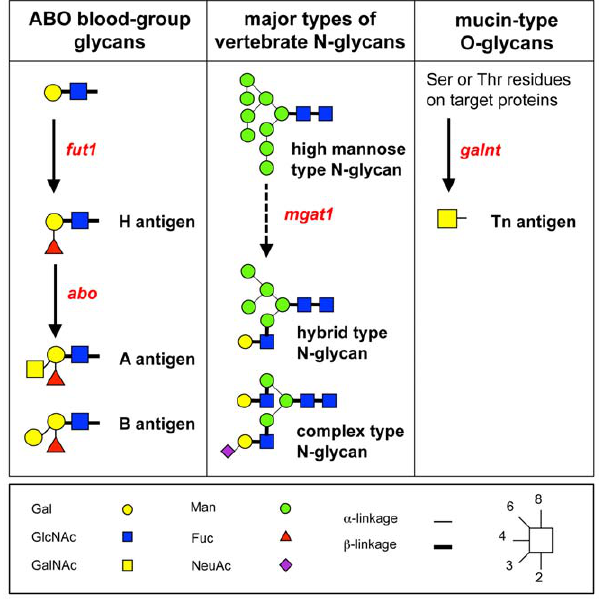
Figure 4. Schematic relationships between the glycans and transferase genes, whose expressions differed significantly between early- and late-stage embryos in this study. Glycosyl- transferase genes are indicated in red. The mgat1 gene does not directly produce hybrid type or complex type of N-glycans, but a high expression level of mgat1 reduces levels of high-mannose-type N- glycans and increases the production of hybrid and complex-type N-